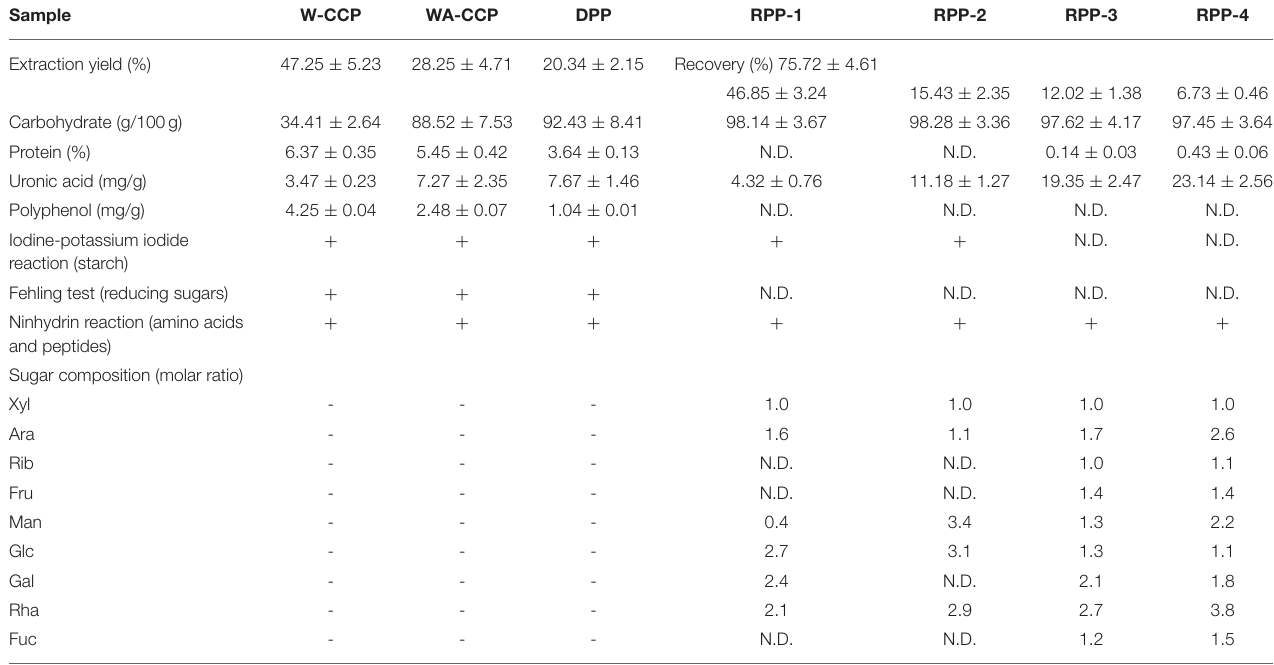
N.D.,Notdetected;W-CPPs,water-extractedcrudepumpkinpolysaccharides;WA-CPPs,crudepumpkinpolysaccharidesextractedbywaterandalcohol;DPPs,deproteinizedpumpkin polysaccharides; RPPs, refined pumpkin polysaccharides. Each value is expressed as the mean ± SD (n =